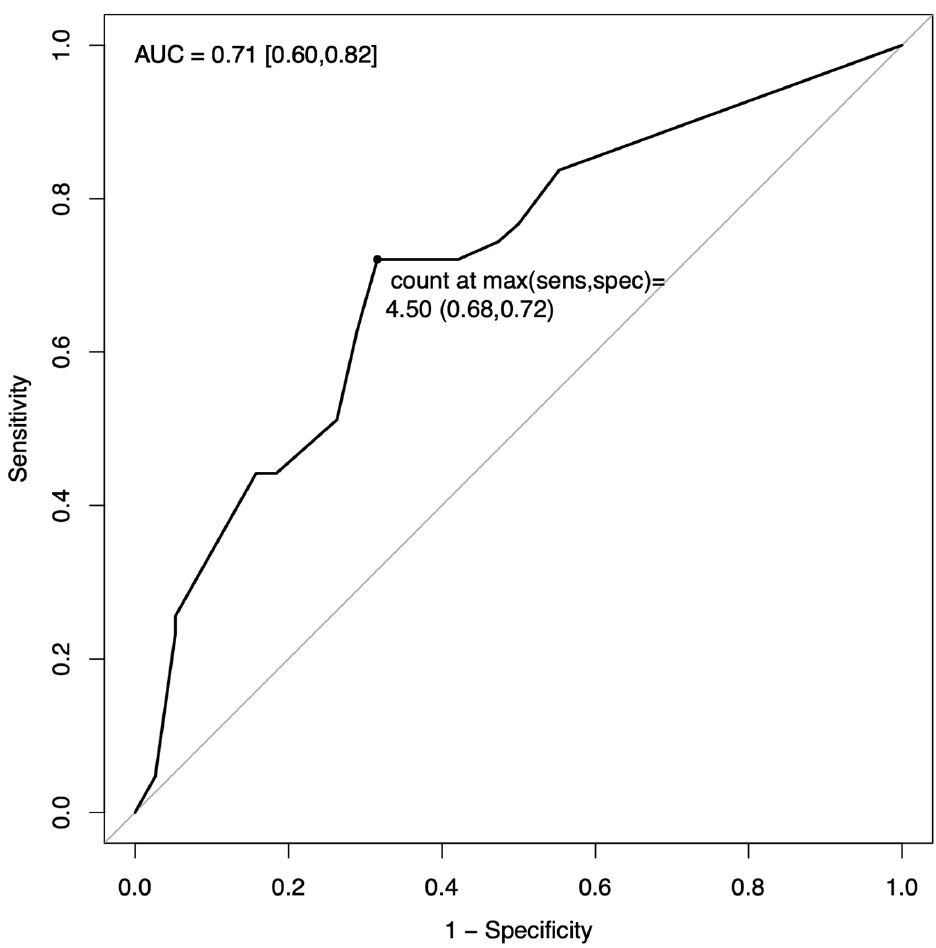
Figure 2. Receiver Operating Characteristic (ROC) curve for ischemia predicting abuse. Area under the curve (AUC) with 95% CI is shown for the number of brain regions with ischemia. The maximum sensitivity and specificity threshold occurred at 4.5 ischemic regions.